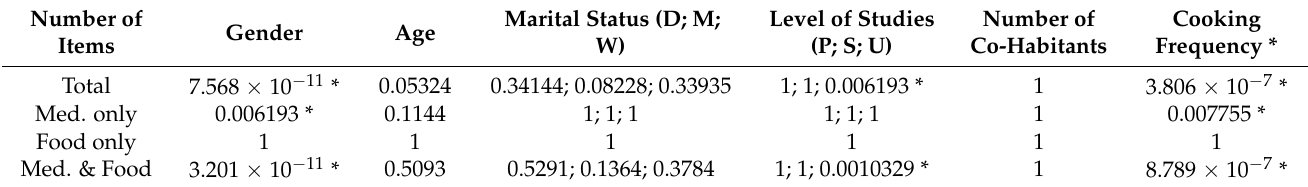
Table 1. p -values for the correlation between number of items listed per informant and socio-demographic descriptive variables (assessed through GLMs family Quasi-Poisson, Bonferroni corrected). Marital status p -values for divorced (D), married (M), and widowed (W) (single as model intercept), and level of studies’ p -values for primary (P), secondary (S), and university (U) (no schooling as model intercept). p -values < 0.05 are marked with an asterisk. “Med. & Food” items are those for which an informant mentioned both